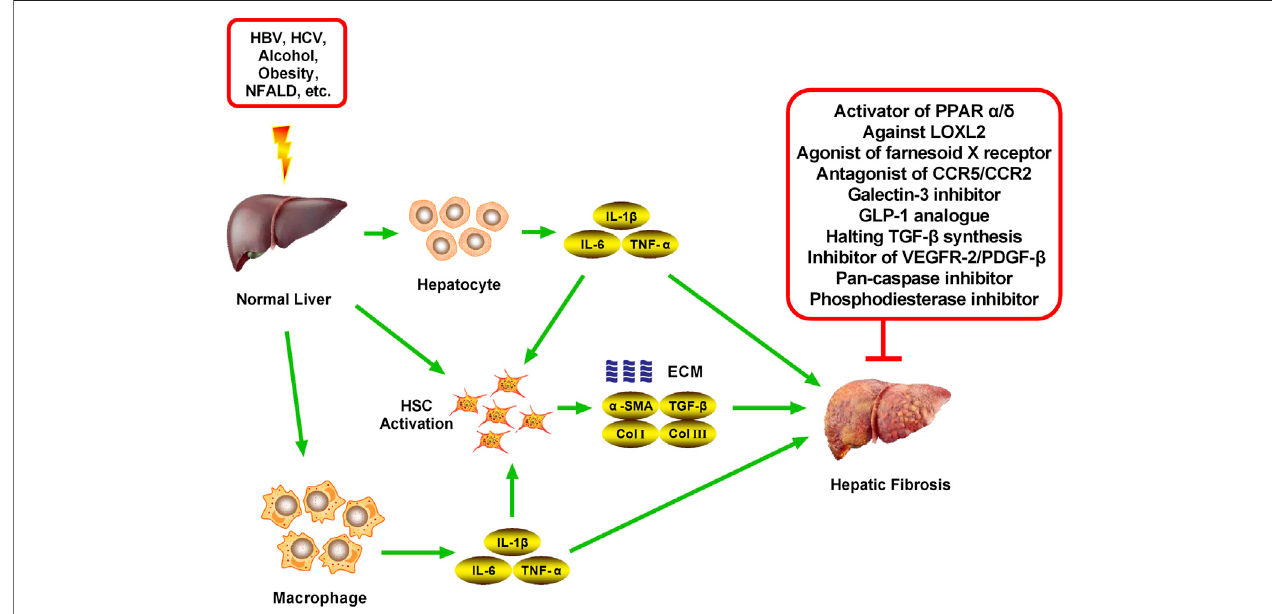
FIGURE 2 | Main targets of new drugs against hepatic fi brosis. Hepatic fi brosis can be induced by various factors, including HBV, HCV, alcohol, obesity, and NFALD, all of which can stimulate the normal liver to induce an in fl ammatory response. Various cells in the liver, mainly hepatocytes, macrophages, and HSCs, secrete in fl ammatory cytokines (mainly IL-1 β , IL-6, and TNF- α ) after receiving stimulation. A large number of in fl ammatory cytokines continuously stimulate HSCs, inducing activation, proliferation, and thesecretion ofmany fi brosiscytokines, including α -SMA,TGF- β ,collagen-I, andCollagen- Ⅲ , whichareimportantcomponents ofthe ECM.Thechronicaccumulation ofECMeventuallyleadstohepatic fi brosis.InhibitingtheactivationandproliferationofHSCs andreducingtheaccumulation ofECMare the mostimportantmethods toreversehepatic fi brosis. Numerous recent studies have foundmany targetsforinhibiting the process ofhepatic fi brosis, whichhas ledto the development of novel therapeutic drugs, mainly activators of PPAR α / δ , agonists of FXR, antagonists of CCR2/5, Galectin-3 inhibitor, GLP-1 analog, inhibitors of VEGFR-2/PDGF- β , LOXL2 inhibitor, Pan-caspase inhibitor, a Phosphodiesterase inhibitor, and TGF- β signaling